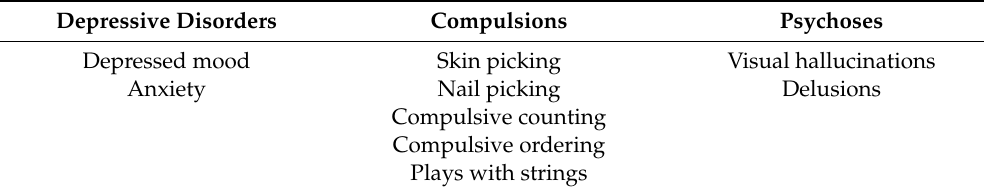
Table 1. Psychiatric behaviors grouped into three